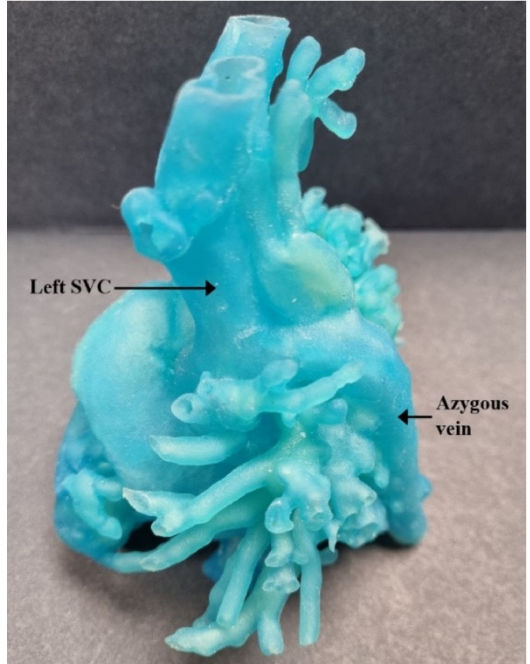
Figure 3. Pre-operative 3D cardiac model demonstrating relationship between hemiazygos vein and left SVC. SVC = superior vena